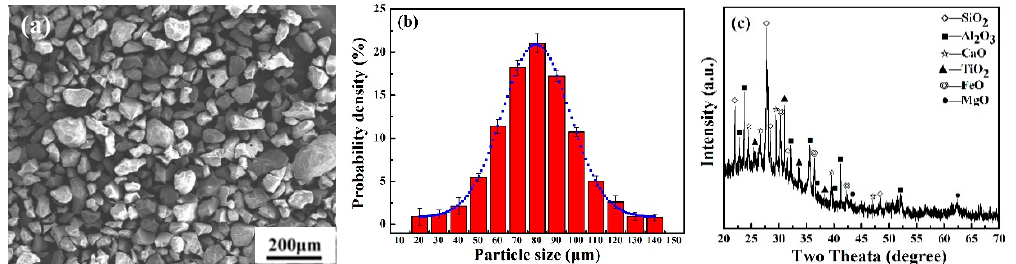
Figure 1. Microstructures of simulated lunar regolith particles: ( a ) morphology shown via secondary electron SEM images, ( b ) Gaussian distribution of particle size and ( c ) phase composition shown by XRD diffraction pattern.